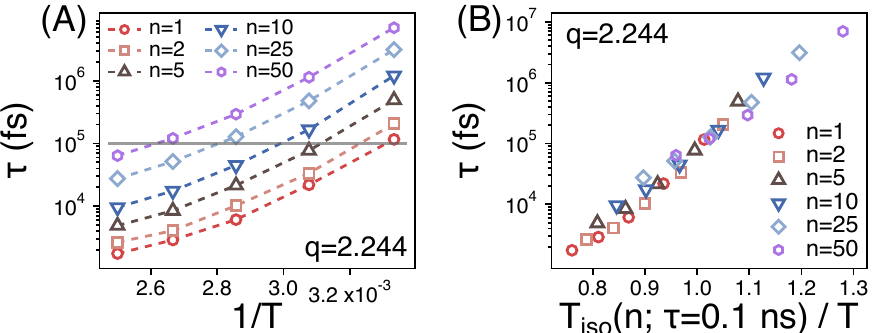
Figure 8. ( A ) The relaxation times ( τ n ) of spatiotemporal correlations of strands of size n as functions of 1/ T ; ( B ) τ n as a function of the rescaled temperature. T ( n ; τ n = 0.1 ns) is the temperature at which τ n = 0.1